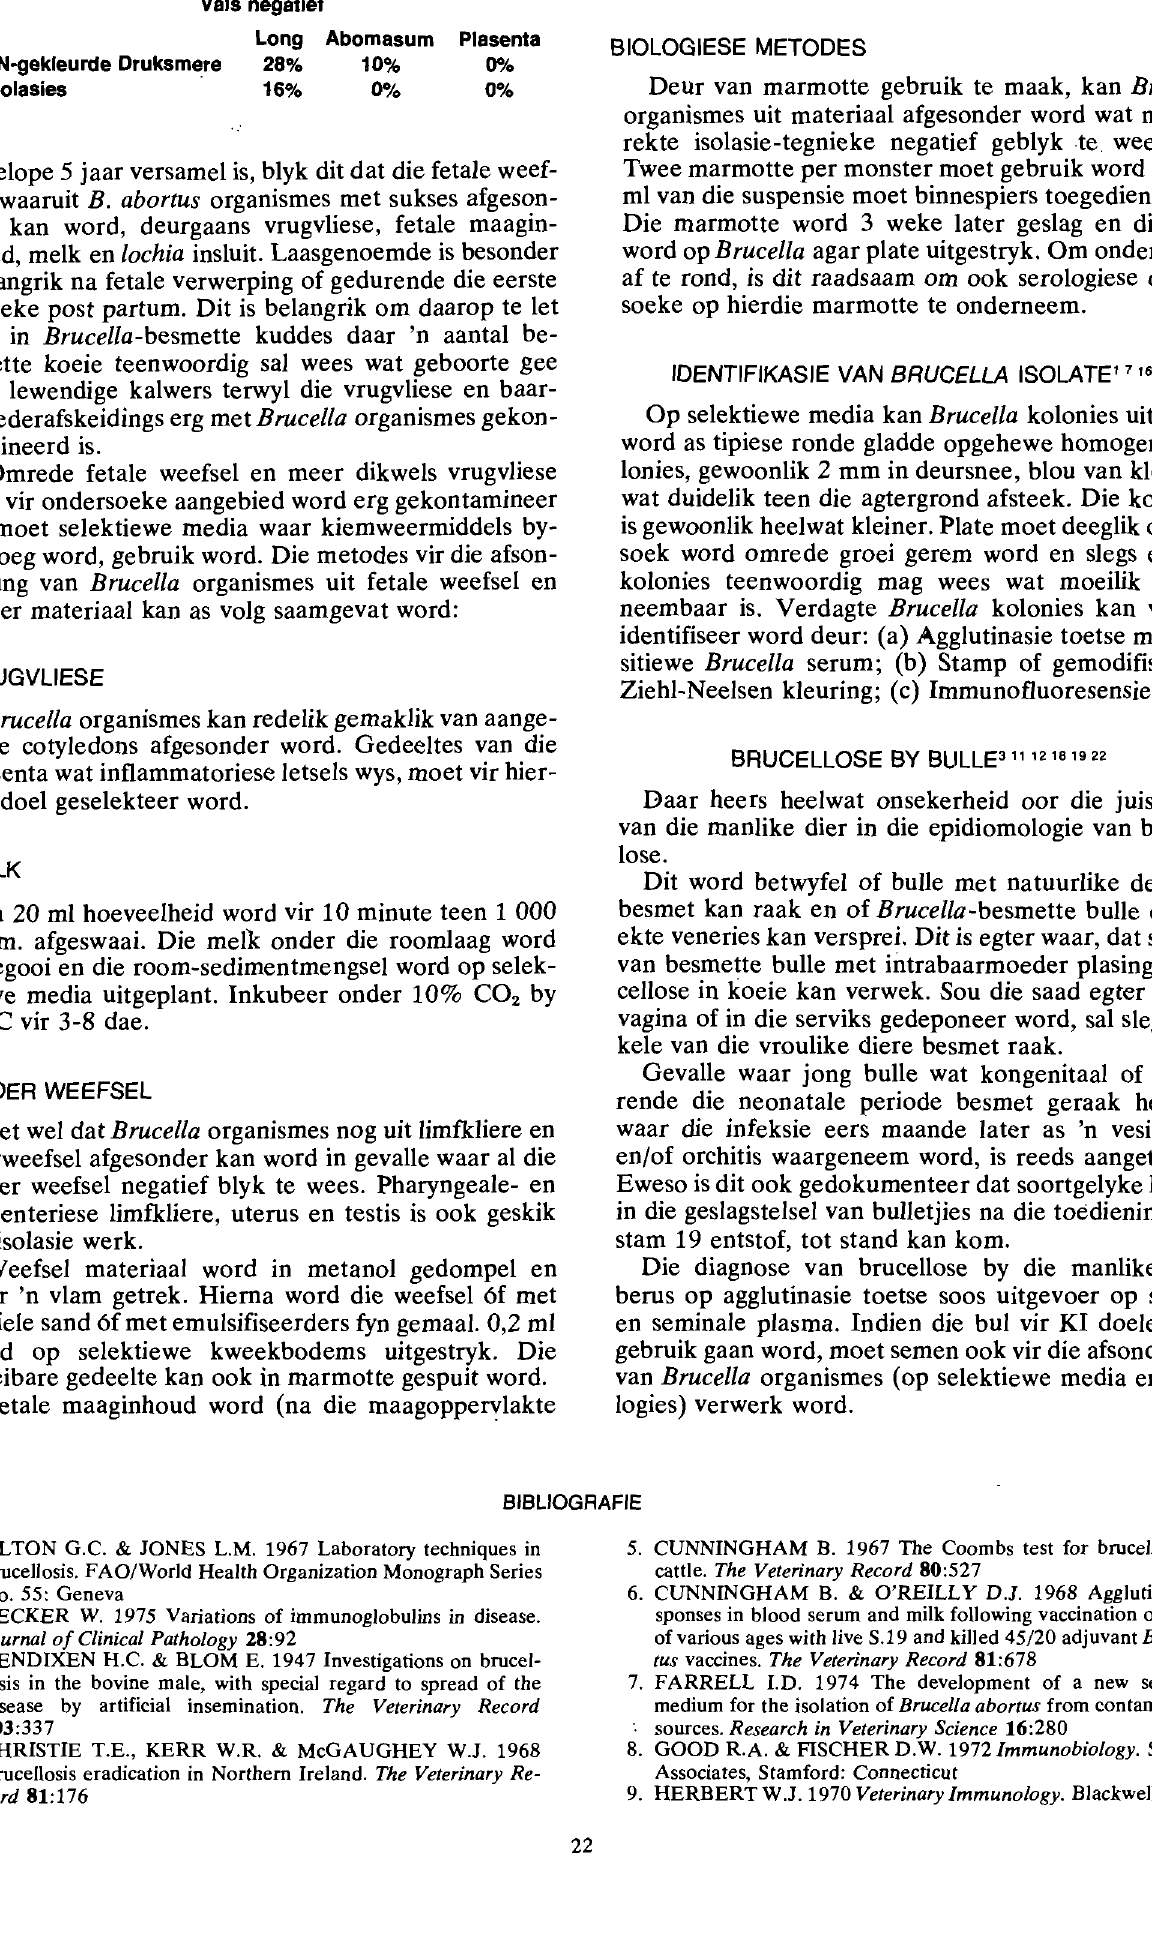
Tabel4: IDENTIFIKASIE VAN BRUCELLA ORGANISMES IN FETALE MATERIAAL Vals